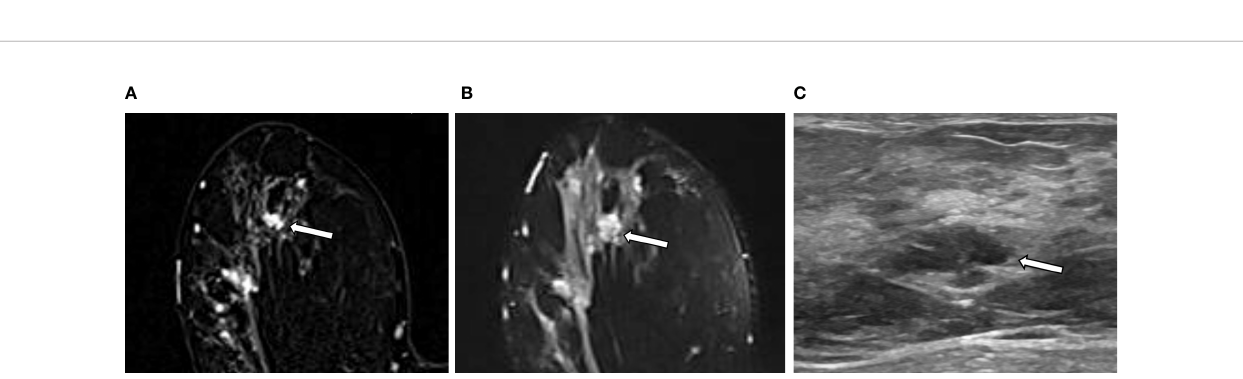
FIGURE 4 | An example of a true negative result by the radiomics analysis (RA) model in a 36-year-old woman with invasive carcinoma of no-special-type in the right breast. (A, B) A 1.1-cm irregular heterogeneously enhancing mass (arrow) with high signal intensity on T2-weighted image is seen in addition to the index tumor [ (A) axial fi rst postcontrast T1-weighted image with subtraction; (B) axial T2-weighted image]. (C) Ultrasound image shows the corresponding 1.1-cm-sized mass with microlobulated margin (arrow). It was classi fi ed as suspicious lesion and the mass was excised. The RA model developed in this study categorized it as benign. The fi nal histologic analysis revealed papilloma with epithelial